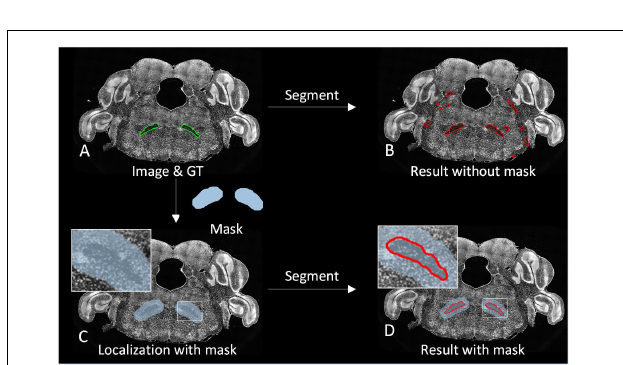
FIGURE 2 | The architecture of dual-pathway CNN. The network consists of dual pathways that take the smaller and larger patch as input, respectively. Each pathway has three hidden layer which have the main components of a convolutional layer, a ReLU layer, an LRN layer, and a pooling layer. The dual-pathway feature maps form the input to a full connection and a convolution layer. All are concatenated after a full connection, and the SoftmaxWithLoss classifier is applied at the end.